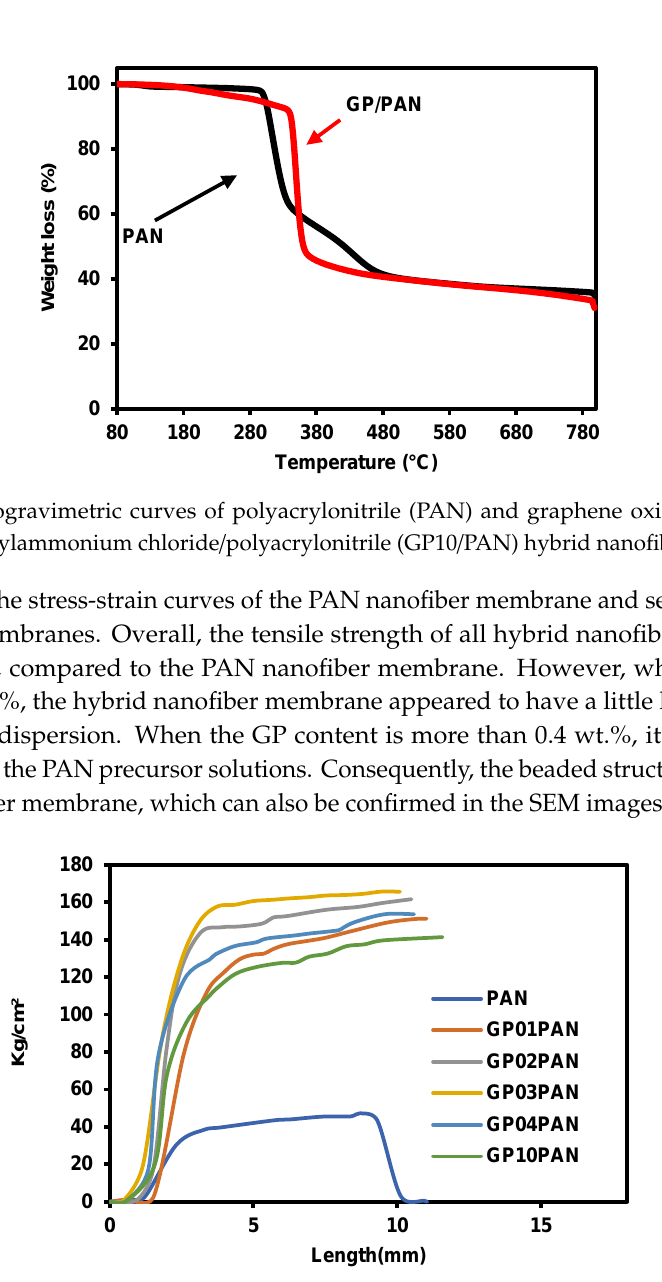
Figure 9. Tensile strength of polyacrylonitrile (PAN) nanofiber and graphene oxide modified by polydiallyldimethylammonium chloride/polyacrylonitrile (GP/PAN) hybrid nanofibers.